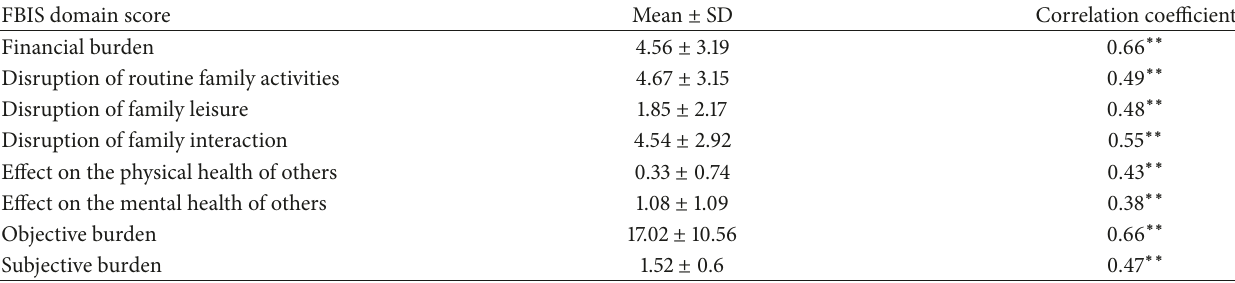
Table 3: Correlation between the severity of dependence and the burden on the